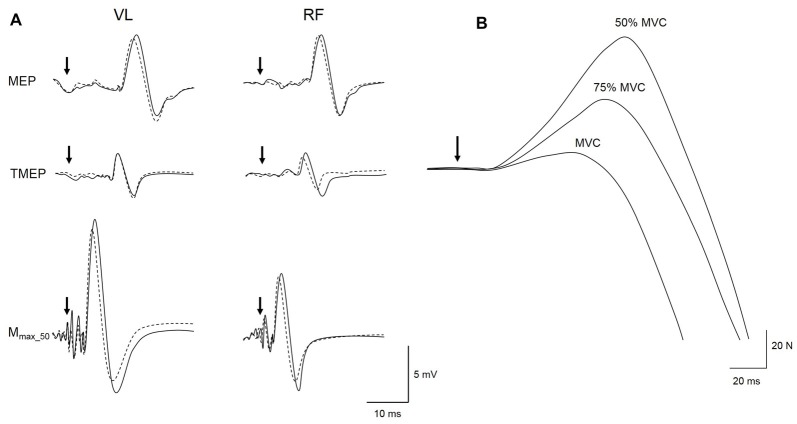
Representative trace of a MEP, thoracic motor evoked potential (TMEP) and M-wave (Mmax_50) recorded for local vibration (LV) session at PRE (solid line) and POST (dotted line) during a 50% maximal voluntary contraction (MVC) submaximal voluntary contraction on VL and RF muscles (A). Raw traces from a single subject of the TMS superimposed twitches (SIT) evoked during maximal (MVC) and submaximal voluntary contractions at 75 and 50% MVC are displayed in (B). Black arrows represent the time of magnetic or electrical stimulations.